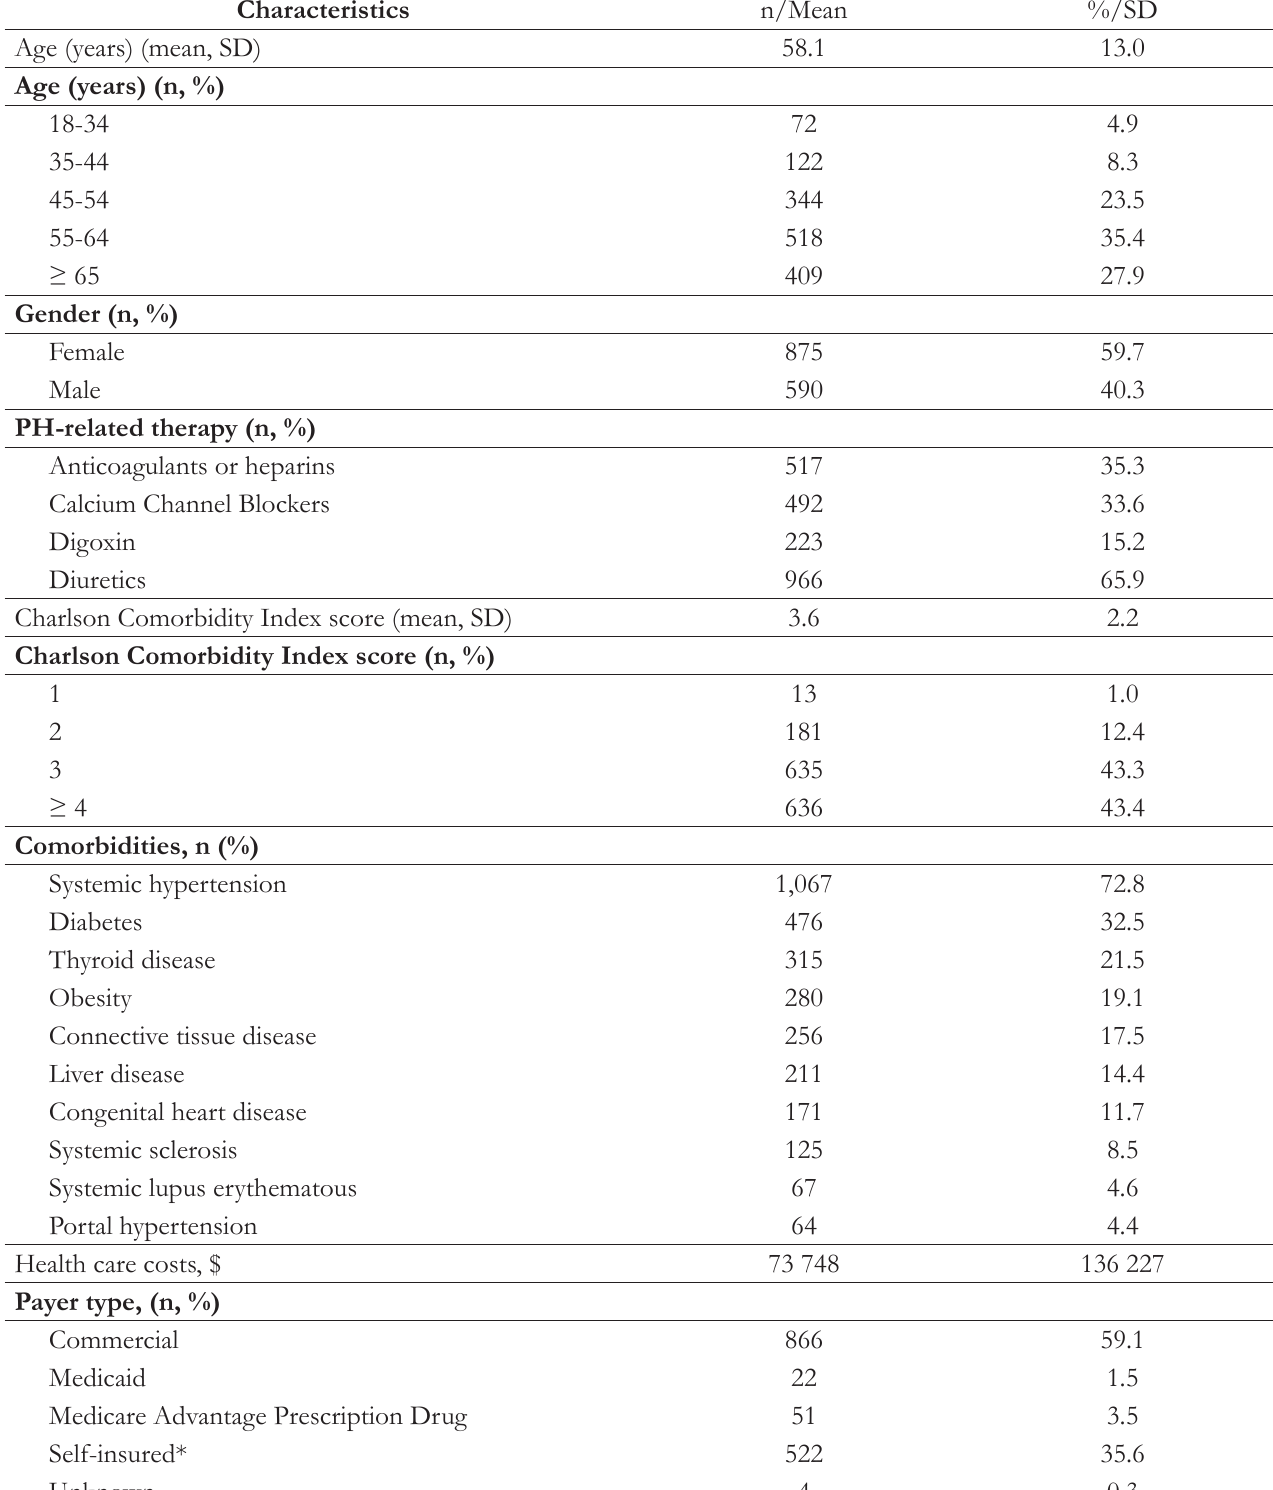
Table 1. Baseline Patient Demographic and Clinical Characteristics (N = 1 465) Characteristics